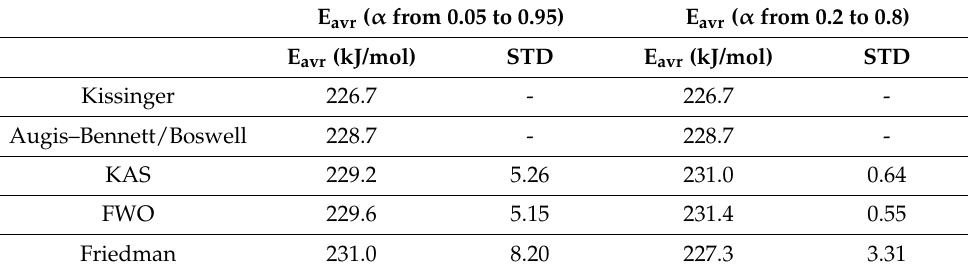
Figure 9. The Flynn − Wall − Ozawa (FWO) method for the EPDM host composite: ( a , b ) ln( β /T2) versus 1000/T; ( c , d ) the dependence of E a and A, respectively, on conversion α . Table 3. The average activation energy values for the EPDM host